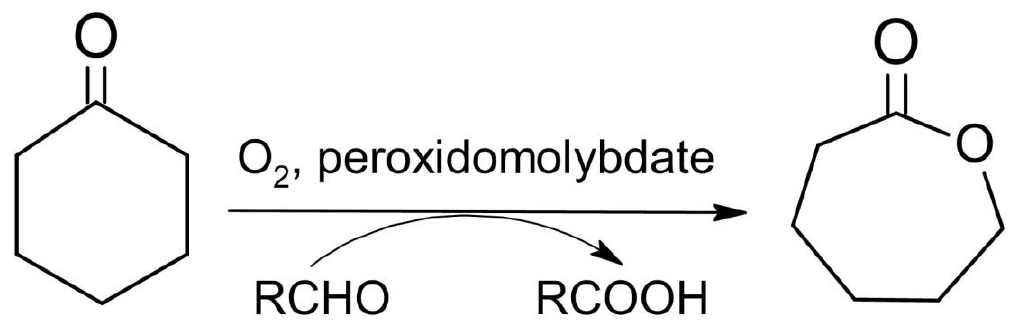
Figure 7. Scheme of the catalytics of the BV cyclohexanone oxidation with molecular oxygen and peroxidomolybdates as catalysts [31].